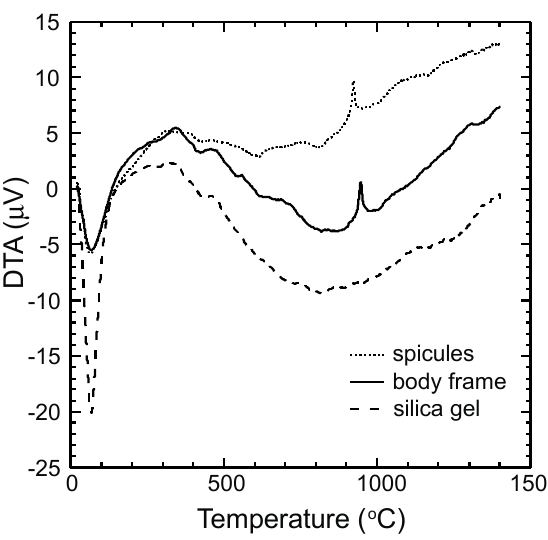
Figure 3. DTA curves for body frame, spicules, and silica gel.